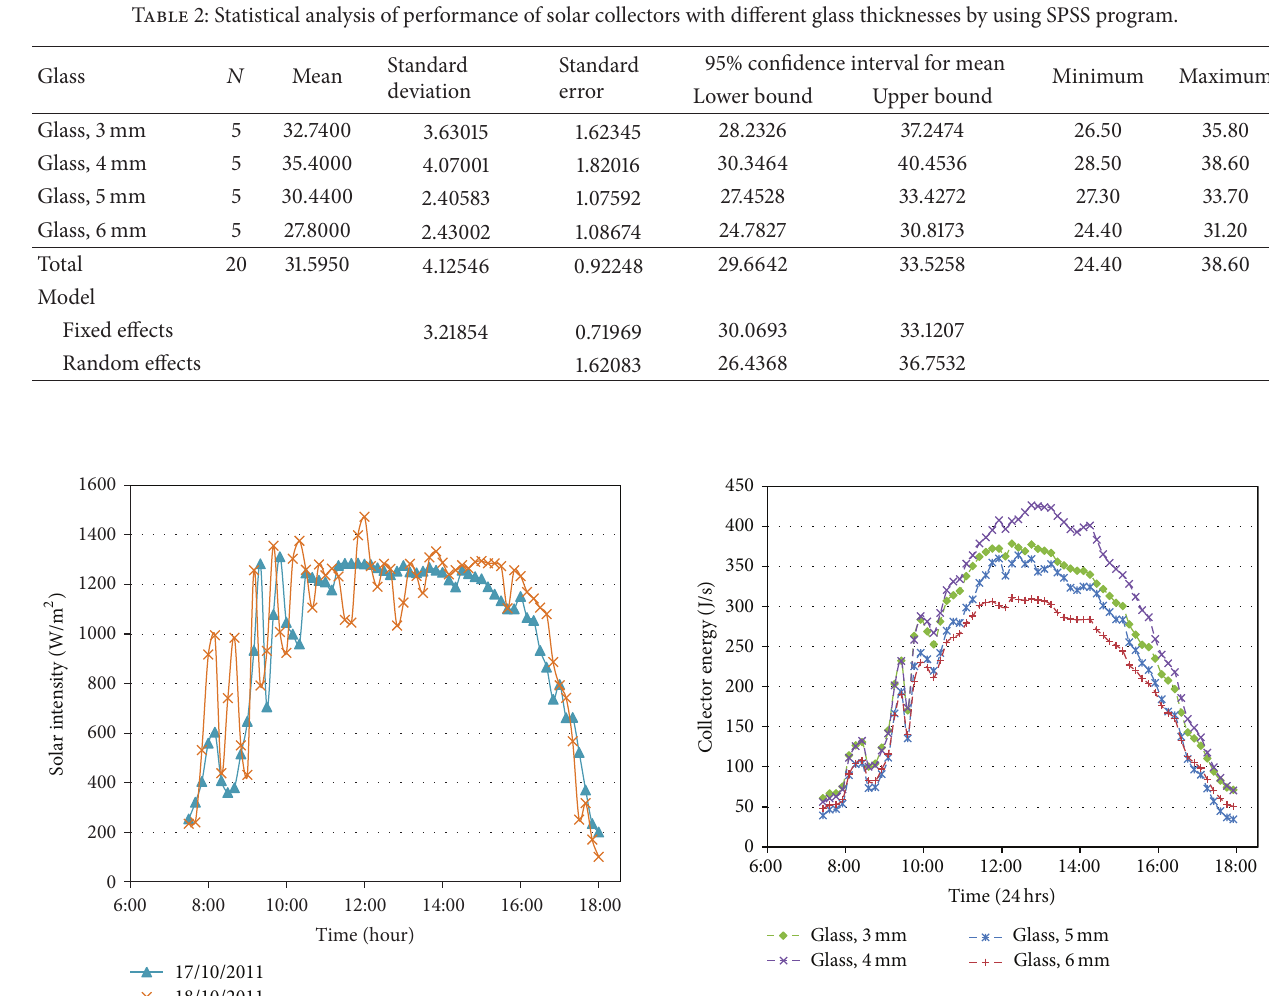
Figure 6: Energy profile of collectors with different glass thickness on October 17,